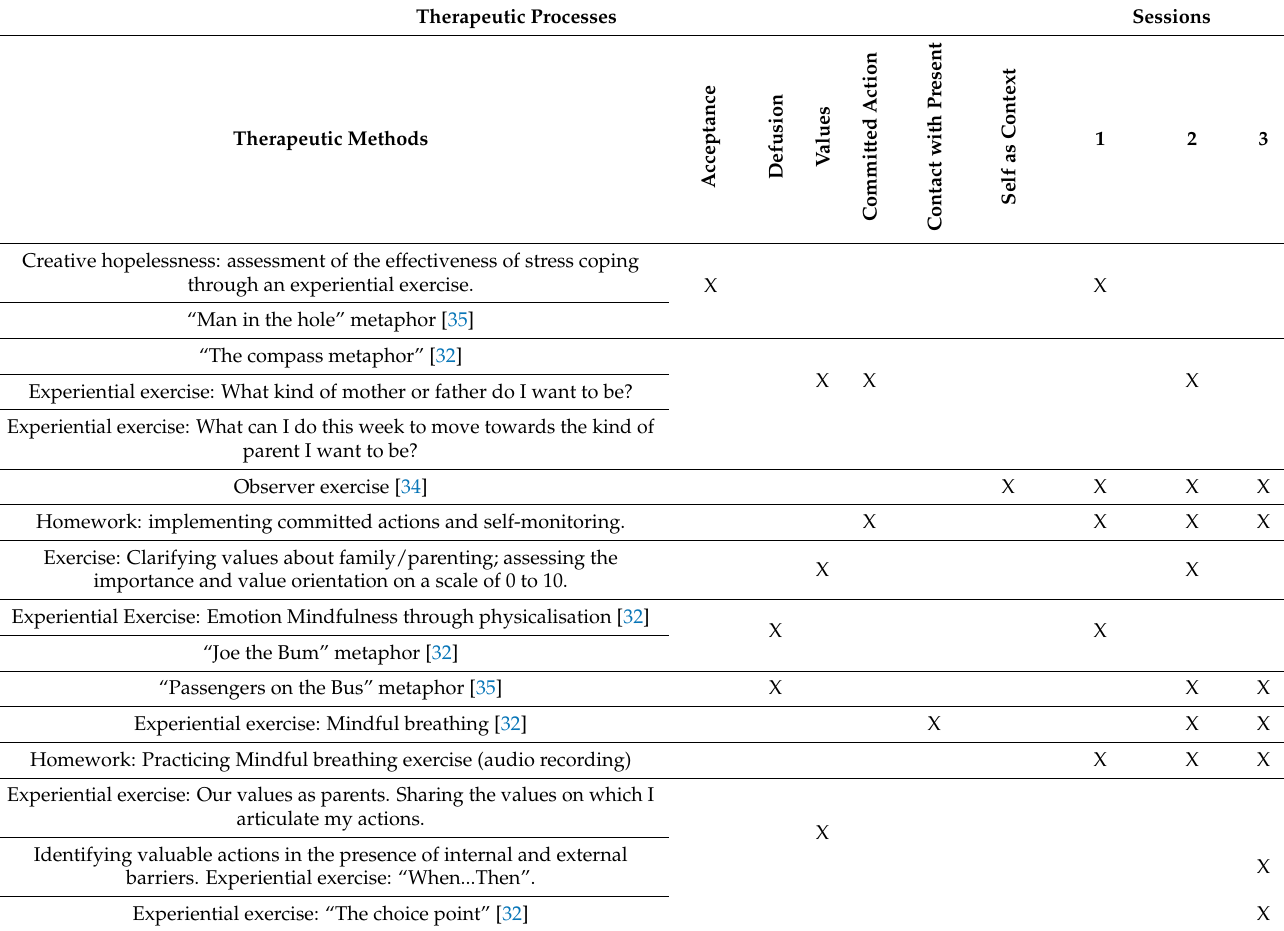
Table 1. Description of the clinical trial intervention